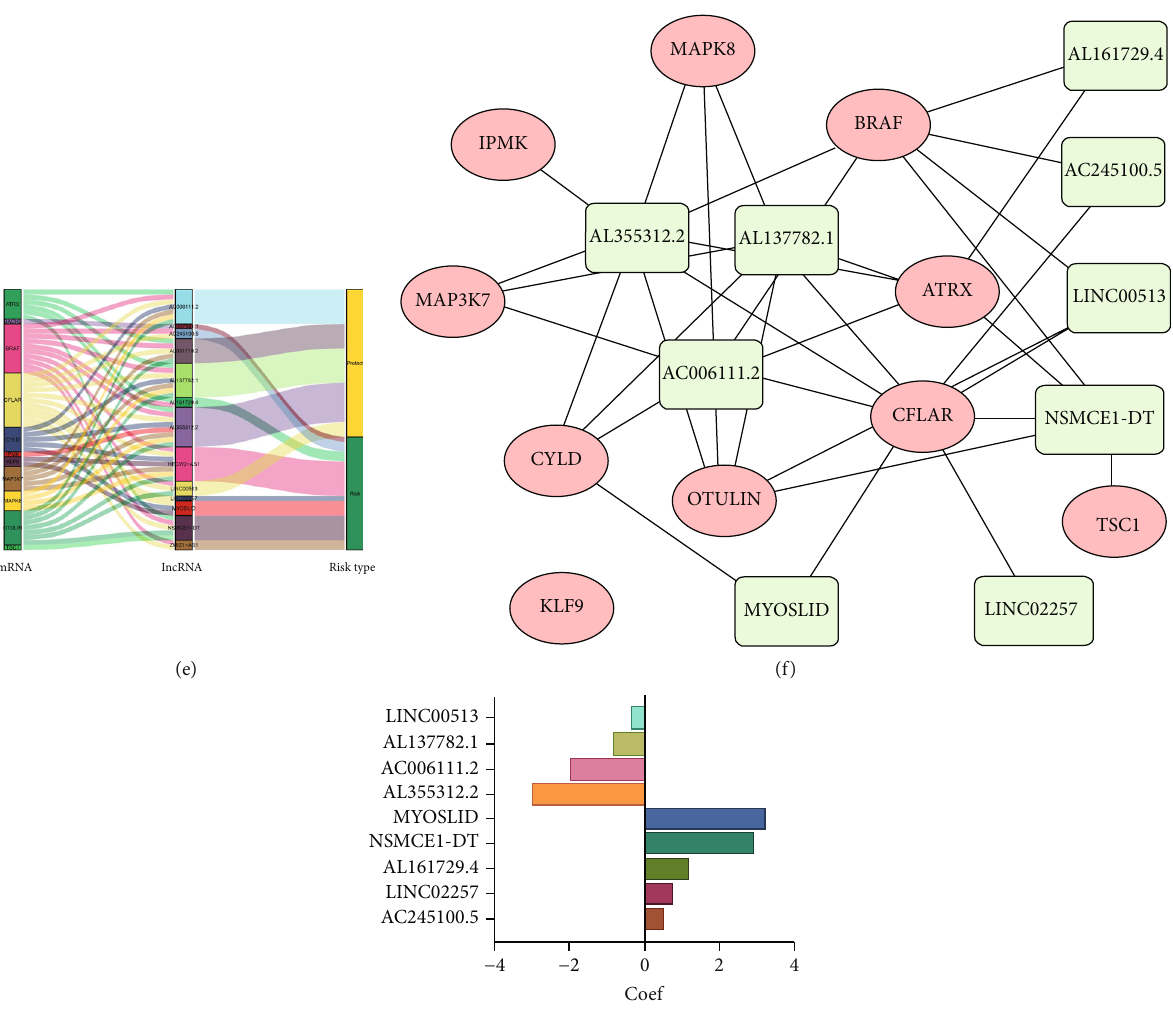
Figure 3: Construction of necroptosis-related lncRNAs ’ prognostic signature for CRC. (a) The forest map of prognostic nrlncRNAs extracted by univariate Cox regression analysis. (b) The expression pro fi les of 19 prognostic nrlncRNAs. (c) The partial likelihood deviance plot presented the minimum number corresponding to the covariates used for multivariate Cox analysis. (d) LASSO coe ffi cient pro fi ling of the 13 nrlncRNAs. (e) The Sankey diagram of the relationship between NRG, nrlncRNAs, and risk type. (f) Network showed the interaction of 9 nrlncRNAs for signature and NRG. (g) The column diagram showed the 9 nrlncRNAs for signature and corresponding coe ffi